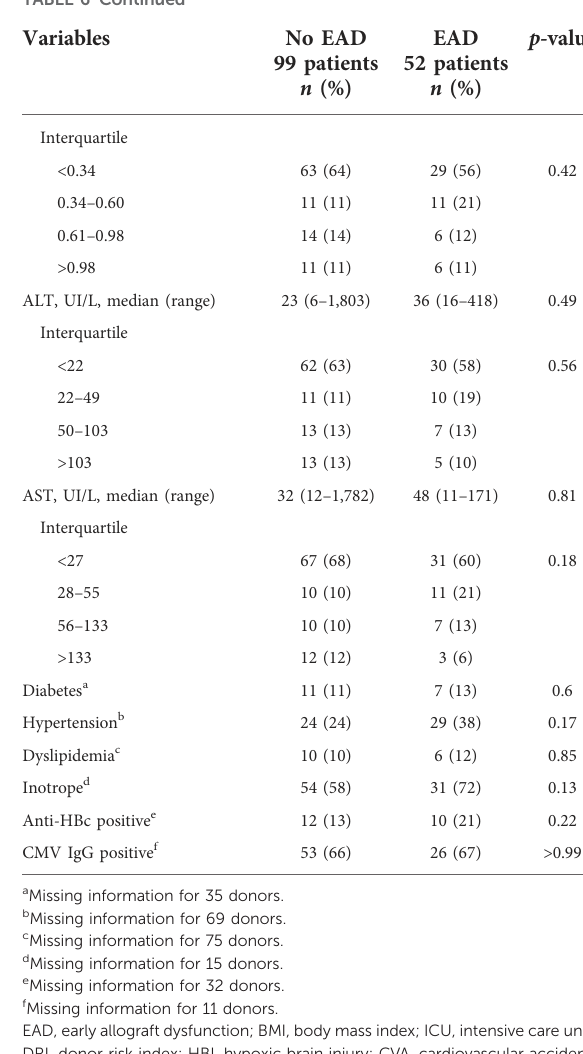
TABLE 6 Univariate analysis of donor factors for developing an